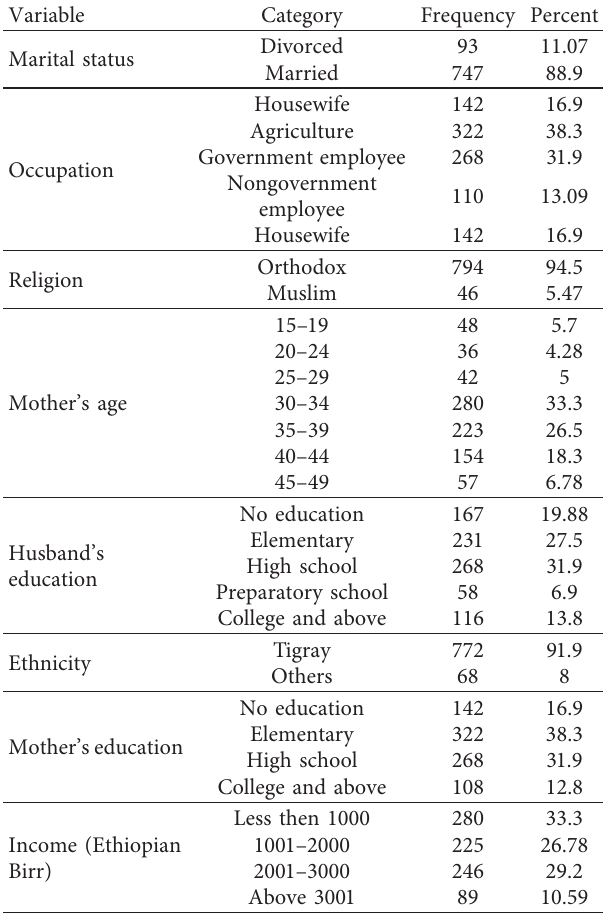
Table 1: Socioeconomic and demographic characteristics of pregnant women in public general hospitals of Tigray Ethiopia 2018 ( n �